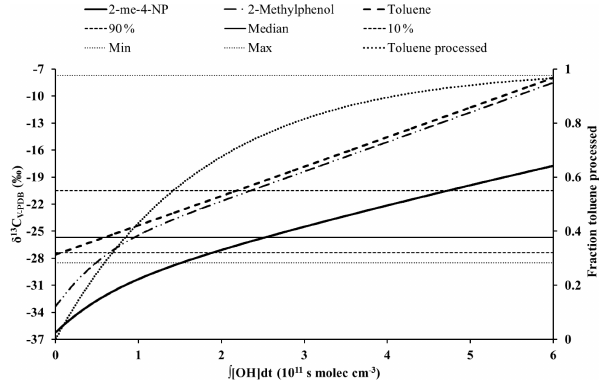
Figure 3. Dependence between the carbon isotope ratio and the PCA ( R [OH]d t ) for 2-methyl-4-nitrophenol, its precursor (toluene), and the phenolic intermediate calculated for Scenario 3. Also shown are the median, the 10th and 90th percentiles, and the lowest and highest carbon isotope ratios for toluene reported by Kornilova et al. (2016) for an urban area in Toronto,